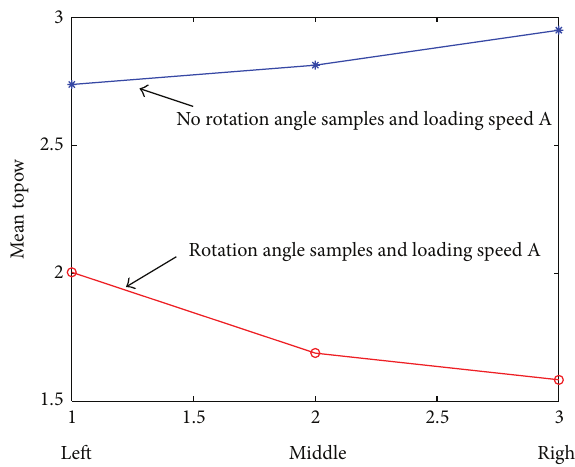
Figure 10: The mean topow of rotation and no rotation specimens under loading speed A.